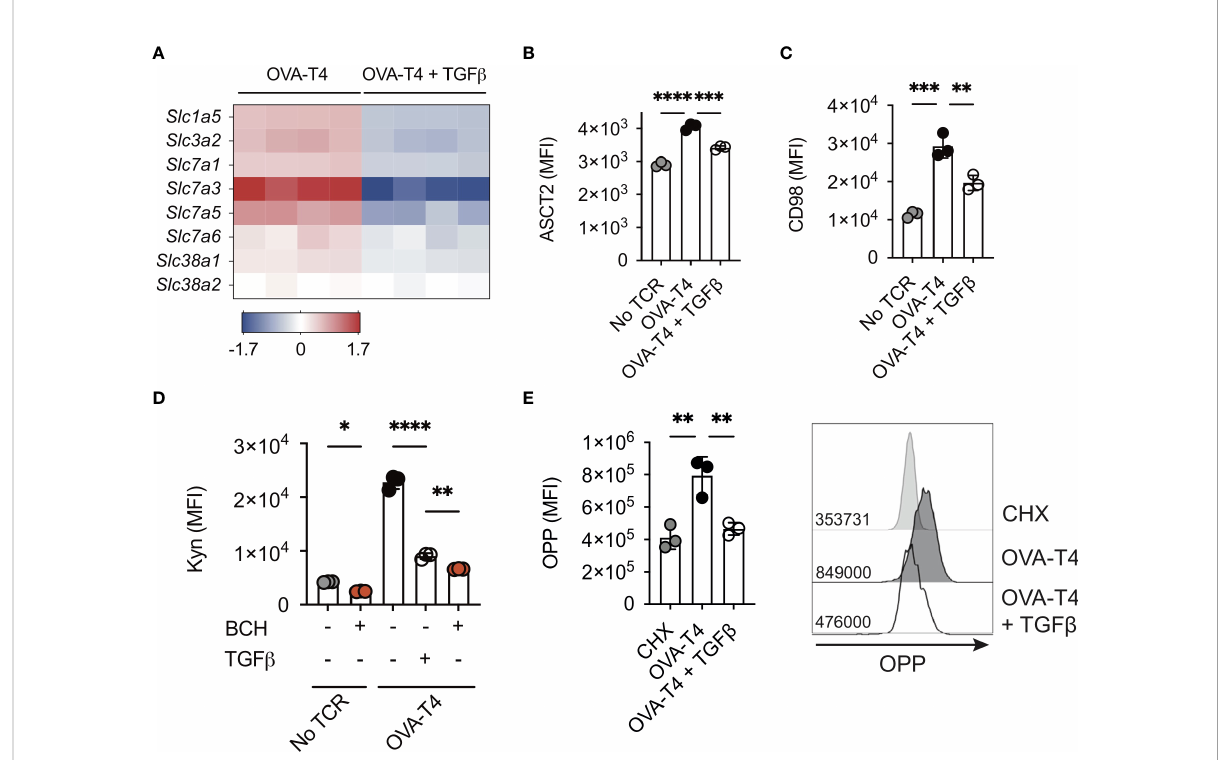
FIGURE 3 TGF b impairs amino acid uptake and protein synthesis OT-I TCR transgenic T cells were stimulated with SIITFEKL (OVA-T4) peptide in the presence or absence of TGF b for 24 (A) or 48 (B – E) hours. (A) The heatmap shows log 2 fold changes in expression of selected amino acid transporter-encoding genes as determined by RNA-sequencing. Levels of surface expression of ASCT2 (B) and CD98 (C) and uptake of kynurenine (D) were determined by fl ow cytometry. To assess requirement for L-type amino acid transporters in Kyn uptake, cells were additionally treated with or without BCH (D) . Incorporation of O-propargyl-puromycin (OPP) was detected by Click chemistry staining and fl ow cytometry (E) . For fl ow cytometry analyses data shown represent mean fl uorescence intensity (MFI) values. Individual data points